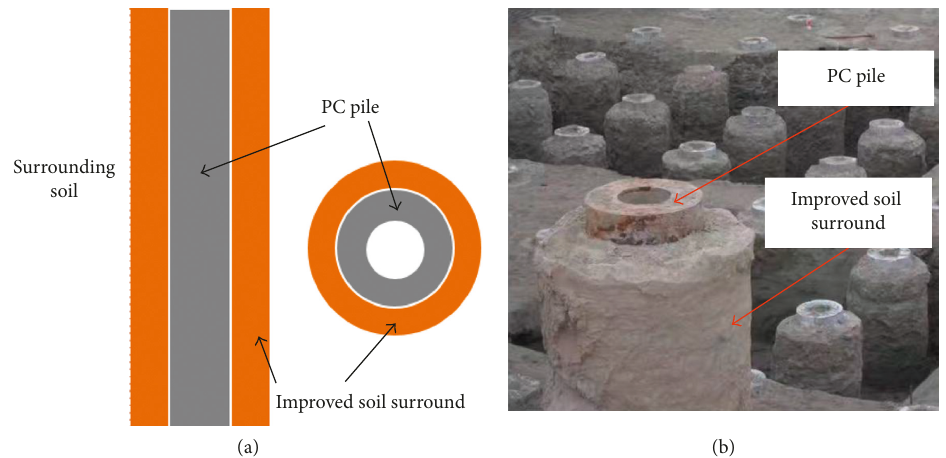
Figure 1: (a) Schematic diagram of PC pile with improved soil surround; (b) photo of field